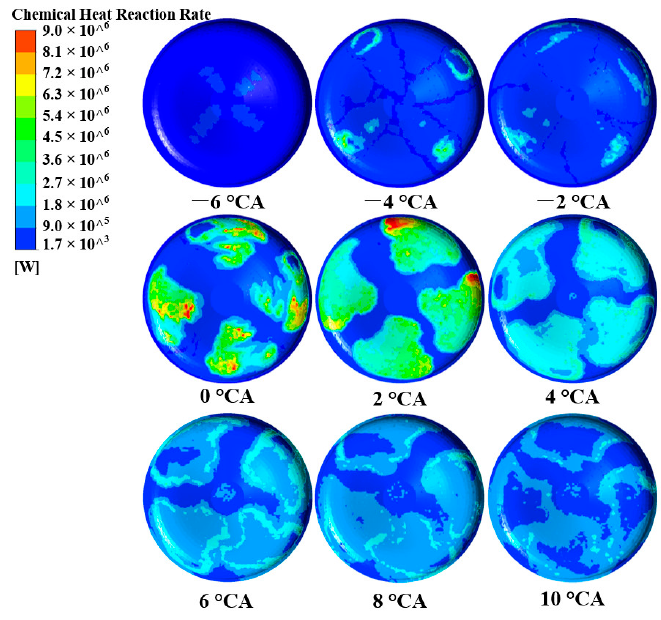
Figure 11. Chemical Heat Reaction Rate at Different Times.